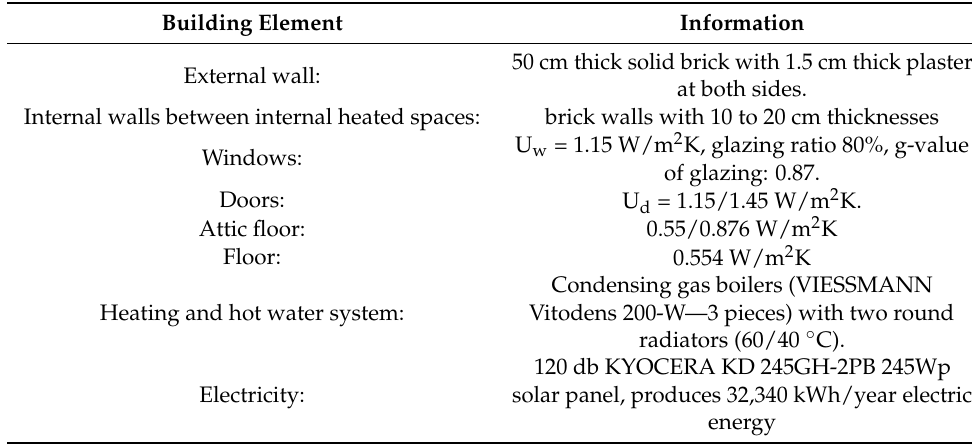
Table A1. Model building parameters—original